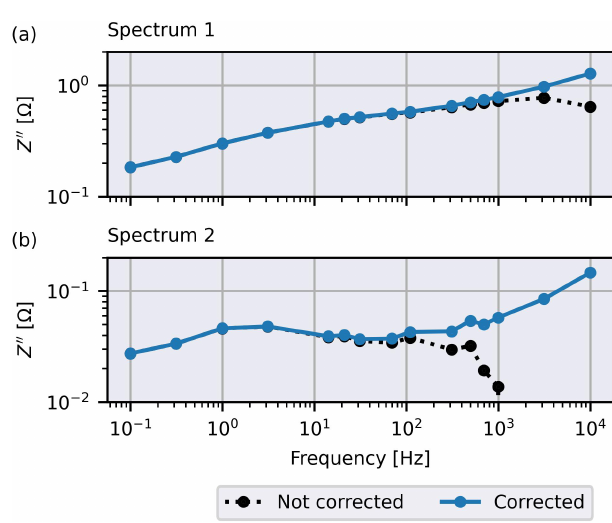
Figure 8. Effect of correction of inductive coupling for two spectra of imaginary parts of the transfer resistance, Z (cid:48)(cid:48) . (a) Least affected spectrum measured on 16 June 2018 (11:00UTC) (b) Most affected spectrum measured on 16 June 2018 (11:00UTC).